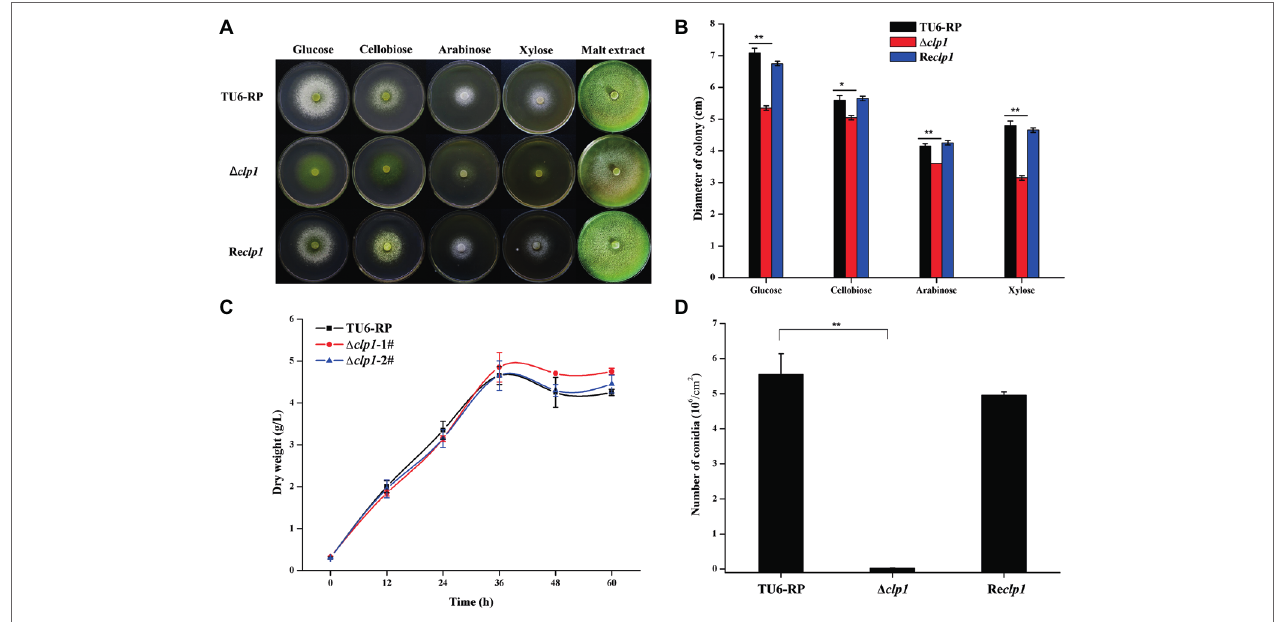
FIGURE 2 | The effect of the absence of CLP1 on the vegetative growth and conidiation of T. reesei . (A) Colony growth of the Δ clp1 , Re clp1 , and TU6-RP strains on different carbon sources and conidia formation on malt extract. (B) Quantitative determination of the colony diameters as shown in (A) . (C) Biomass accumulation of the TU6-RP and two independent transformants of Δ clp1 cultured with 1% (w/v) glucose as the sole carbon source. (D) Counting of conidia formed by Δ clp1 , Re clp1 , and TU6-RP strains with a hemocytometer after cultivation on malt extract agar for 5 days. Significant difference ( t test, * p < 0.05, ** p < 0.01) was observed in colony diameter and conidia formation between the TU6-RP and the Δ clp1 strains. Values represent the mean of two to three biological replicates. Error bars are the SD from these